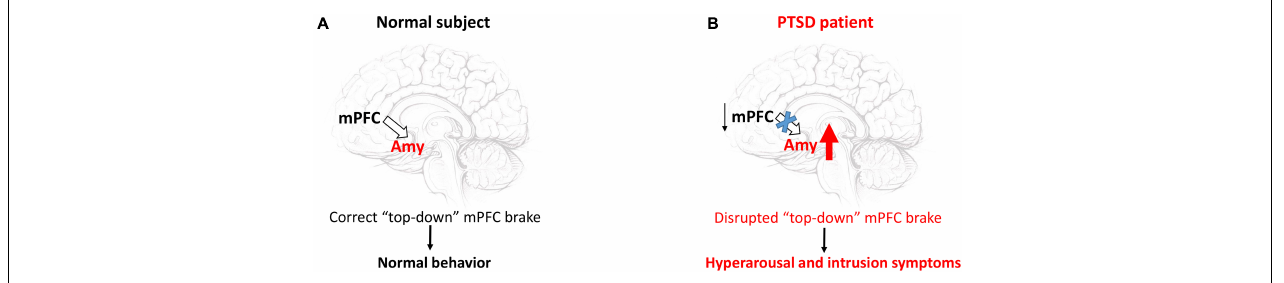
FIGURE 1 | The failure of the “top-down” inhibitory control exerted by the mPFC over the amygdala triggers hyperarousal and intrusion symptoms. In a normal subject (A) , the mPFC exerts a homeostatic inhibitory control over the amygdala (Amy). This “top-down” brake maintains appropriate behavior patterns under stressful conditions. In PTSD patients (B) the hypoactive mPFC removes the brake over the Amy, whose hyperactivity mainly generates hyperarousal and intrusion symptoms (Fenster et al., 2018, see also text).